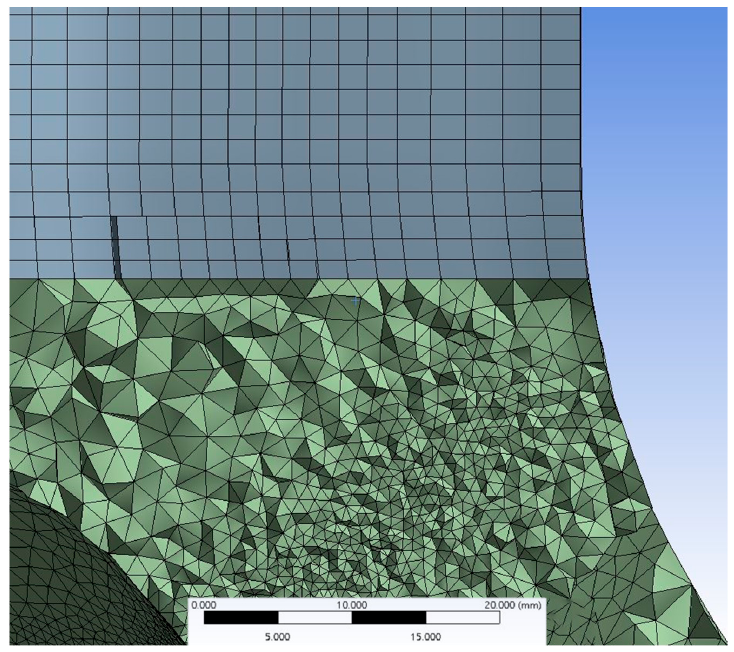
Figure 6. Joint of inlet tube and impeller of mesh .